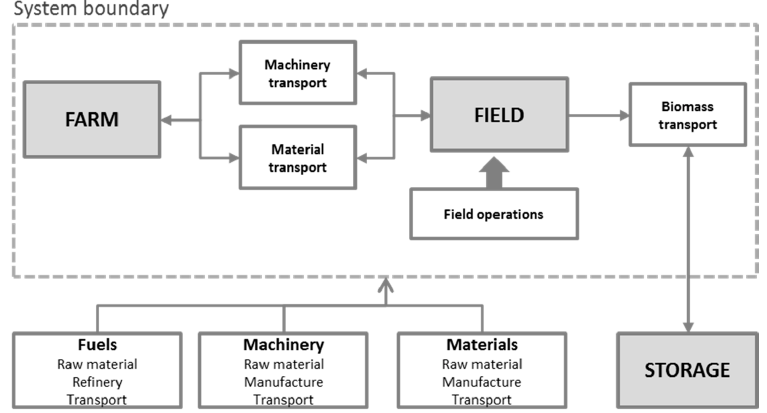
Figure 1. The system boundary for the energy input.